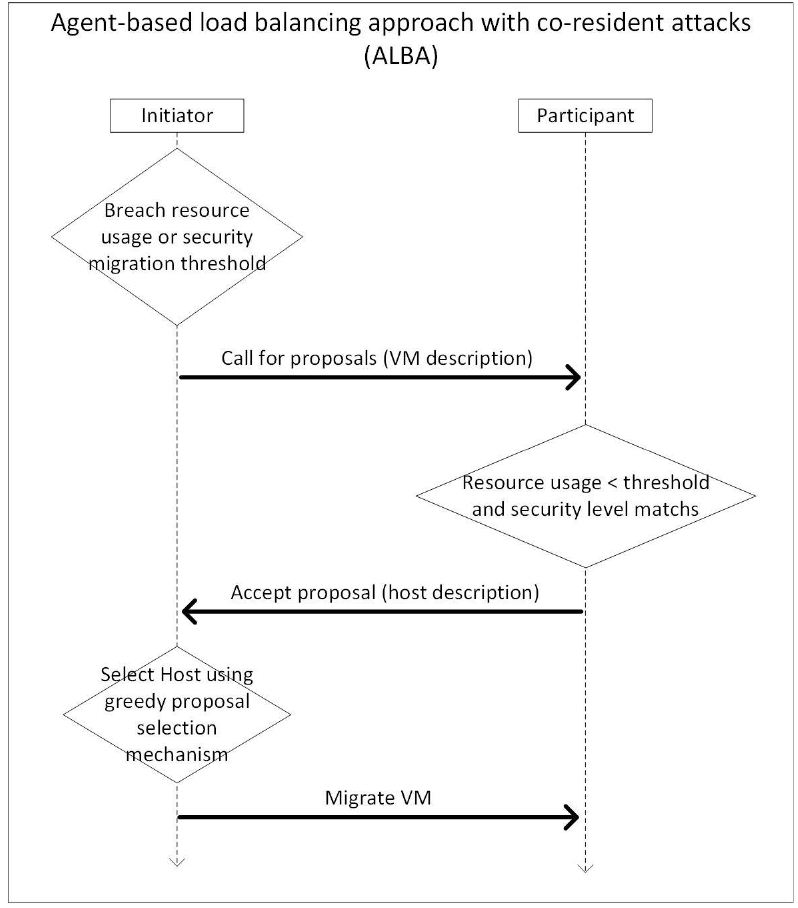
Figure 3. Agent-based VM migration for load-balancing and co-resident attacks (ALBA).